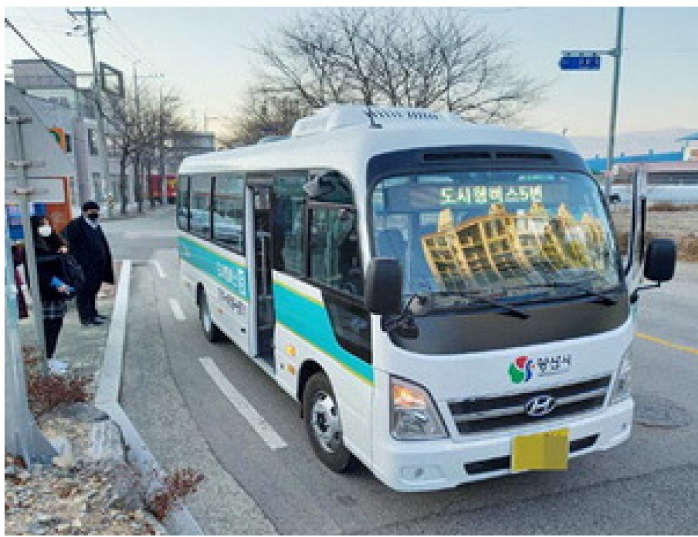
Figure 6. City-type bus in Korea (Yangsan city-type bus No. 5) [29].